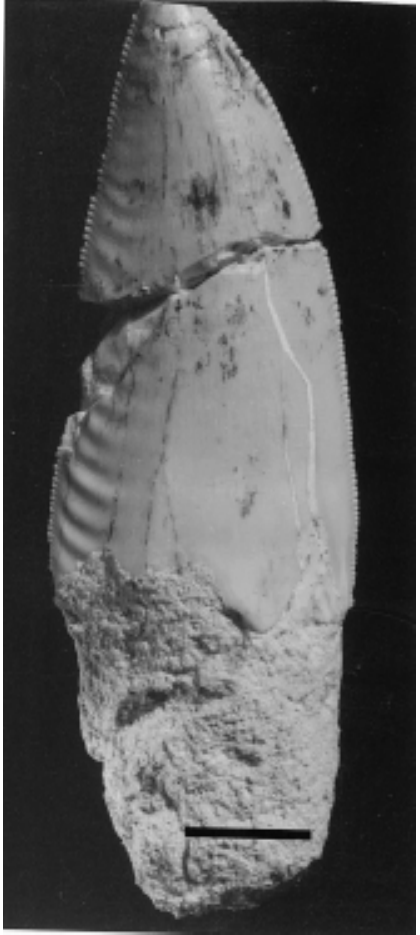
Cretaceous Bauru Group from the locality Serra da Galga, Uberaba, Minas Gerais. Note the wrinkles present particularly on the posterior margin, which are similar to basal tetanurans taxa like Giganotosaurus and Carcharodontosaurus . Scale bar: 10